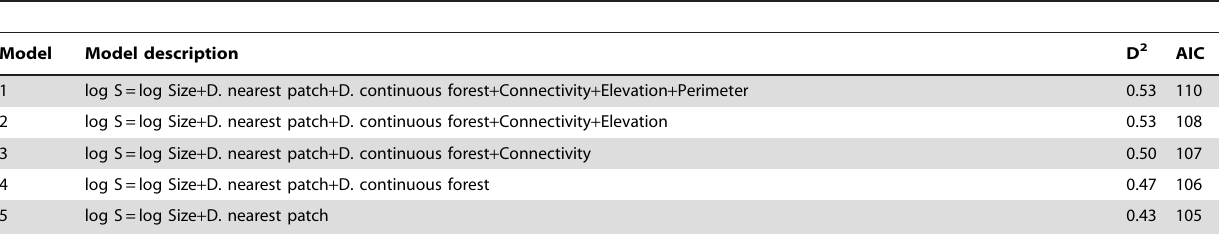
Table 2. Log linear models proposed to explain the variation in plant species density (S) in 19 forest patches on the Yucatan Peninsula.